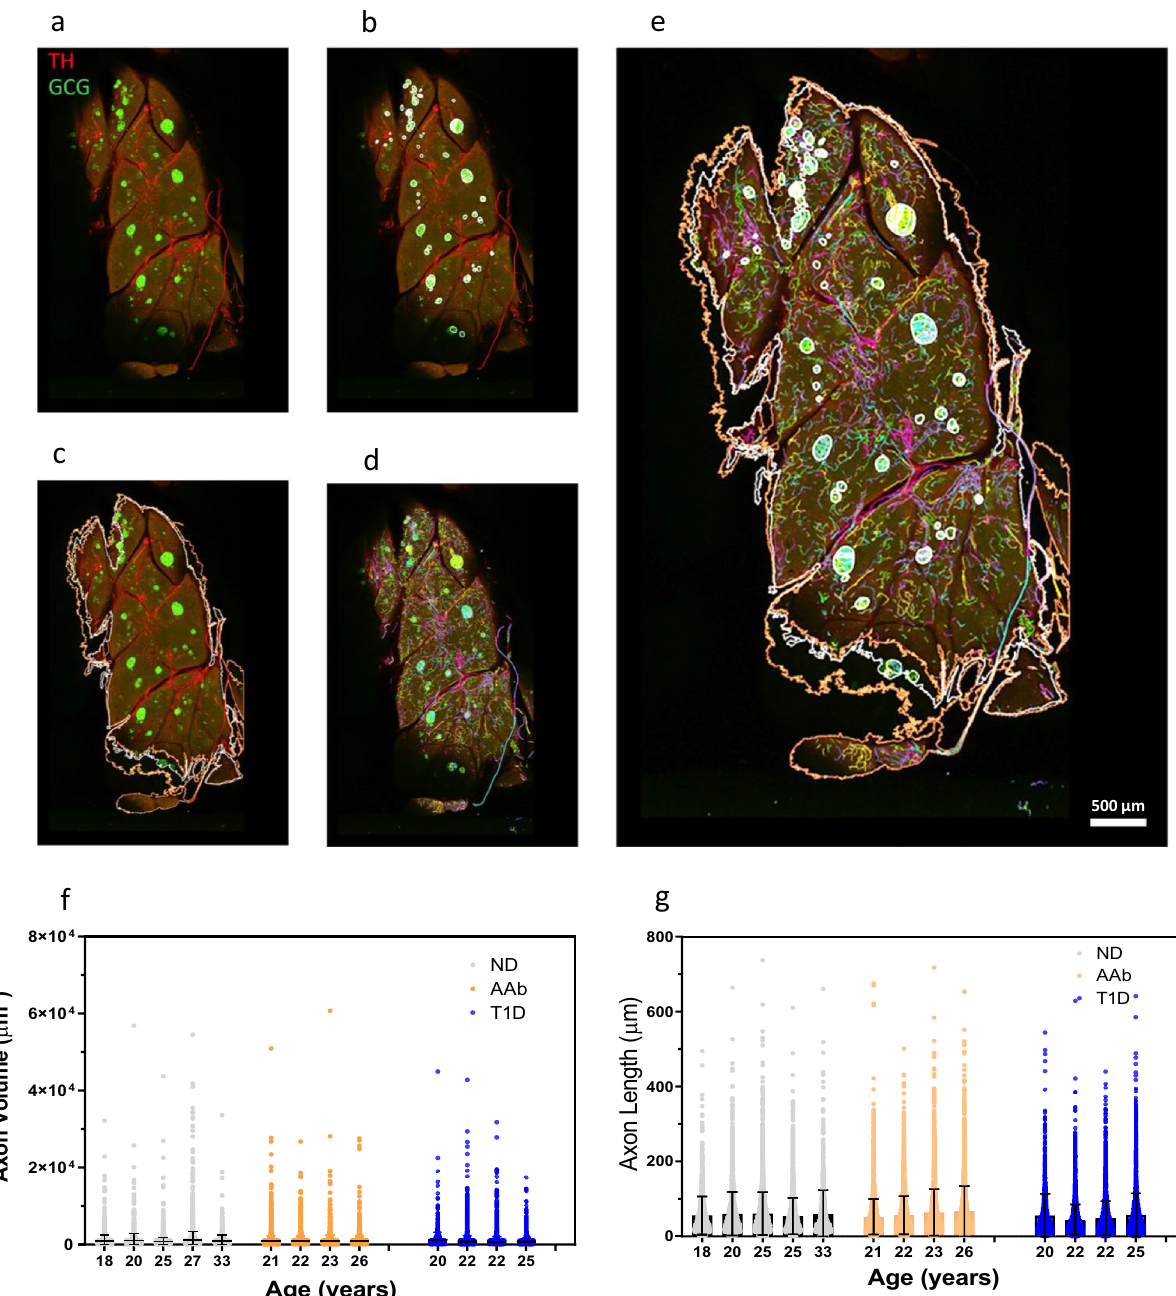
Figure 5. Exocrine pancreas iDISCO image analysis pipeline and TH axon volume and length. ( a ) Maximum intensity projection of a control pancreas slice is shown depicting key image analysis steps with Neurolucida360. TH axons (red) and α-cells (GCG, green) delineate sympathetic axons and islets, respectively. ( b ) Islets are contoured (white) based on GCG signal. ( c ) Slice outlines are shown contoured in white and orange for the first and last slices, respectively, and all slice outlines were used to determine total sample volume (µm 3 ). ( d ) TH axons were automatically traced following thresholding and individual axons were displayed in separate colors. ( e ) Merged image showing overlays of TH axons and islet and slice contours. Scale bar: 500 µm. ( f ) Exocrine TH axon volumes (µm 3 ) were not significantly different between groups. ( g ) Exocrine TH axon lengths (µm) volumes were not significantly different between groups. Data were plotted for all TH axon volumes and lengths per donor (n = 1381–8197 axons/donor) for 4 donors in each group. Statistical significance was tested using 1-way ANOVA for nested